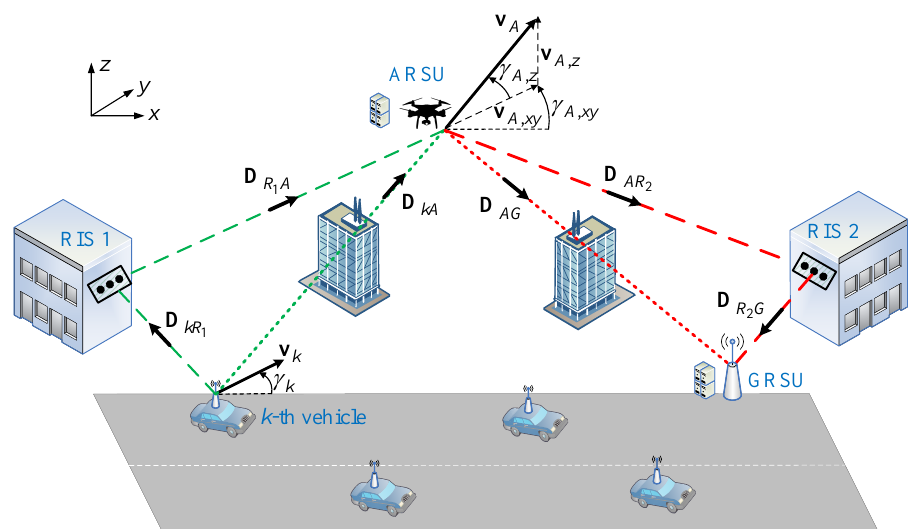
Figure 1. A simple representation of the dual-RIS UAV-aided MEC-enabled IoV